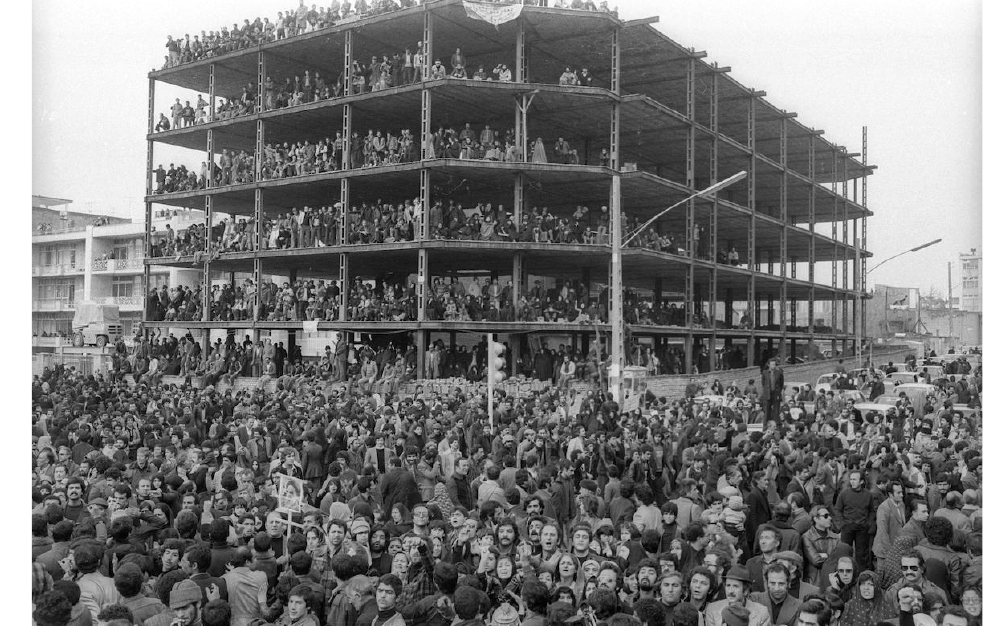
Figure 12. Islamic Revolution, February 1979. Source: Michel Setboun. ples of urban development. Bare frames that